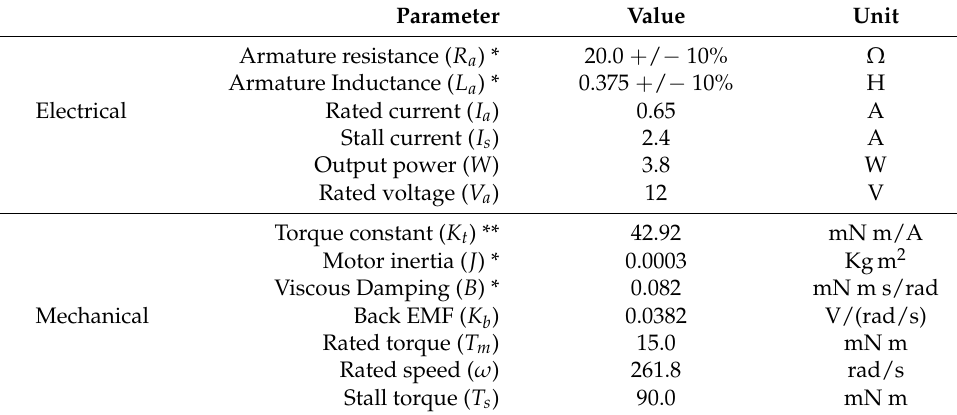
Table 1. 36JX30K/38ZY63-1230 DC motor parameter value.